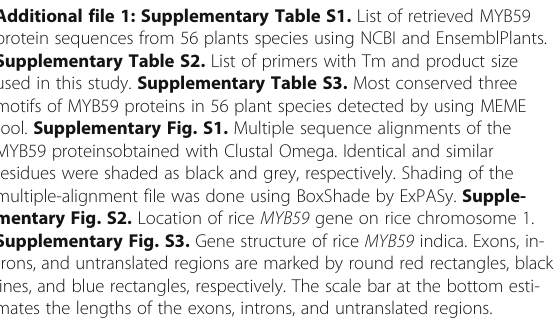
Supplementary Table S2. List of primers with Tm and product size used in this study. Supplementary Table S3. Most conserved three motifs of MYB59 proteins in 56 plant species detected by using MEME tool. Supplementary Fig. S1. Multiple sequence alignments of the MYB59 proteinsobtained with Clustal Omega. Identical and similar residues were shaded as black and grey, respectively. Shading of the multiple-alignment file was done using BoxShade by ExPASy. Supple- mentary Fig. S2. Location of rice MYB59 gene on rice chromosome 1. Supplementary Fig. S3. Gene structure of rice MYB59 indica. Exons, in- trons, and untranslated regions are marked by round red rectangles, black lines, and blue rectangles, respectively. The scale bar at the bottom esti- mates the lengths of the exons, introns, and untranslated